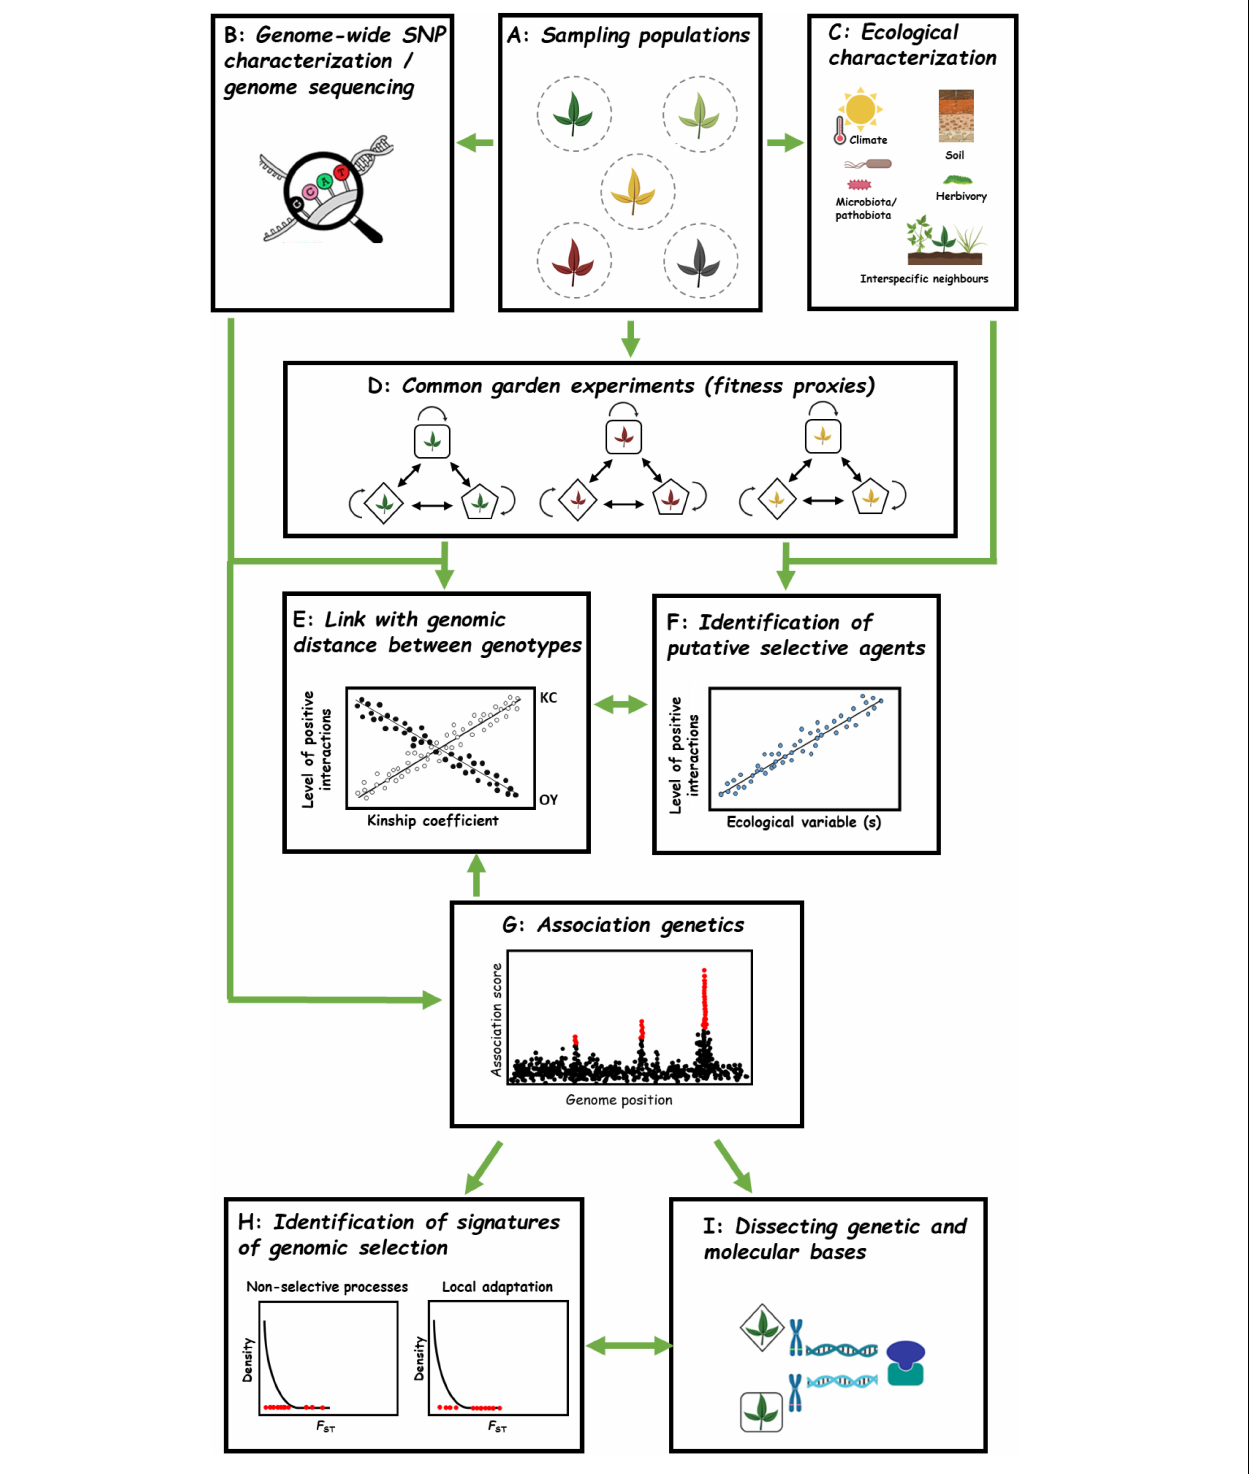
FIGURE 7 | Future avenues for studying GxG interactions among wild plant populations. (A) Collecting multiple genotypes from several natural populations. (B) Genome sequencing/Genome-wide SNP characterization of all genotypes coming from different populations. (C) Characterizing abiotic and biotic ecological factors. (D) Conducting common garden experiments to dissect fitness outcomes in pairwise interactions among genotypes from one population (intragenotype and intra-population intergenotype combinations). Different genotypes are represented by different shapes. (E) Linking genomic distance with levels of positive interactions exhibited in pairwise GxG interactions. (F) Identifying putative ecological driver(s) associated with among-population variation of positive interactions. (G) Genome Wide Association mapping to identify genomic regions underlying positive interactions. (H) Enrichment analysis in signatures of selection, e.g., spatial genetic differentiation estimated by F ST . (I) Cloning and functional characterization of genes underlying QTLs associated with positive interactions.